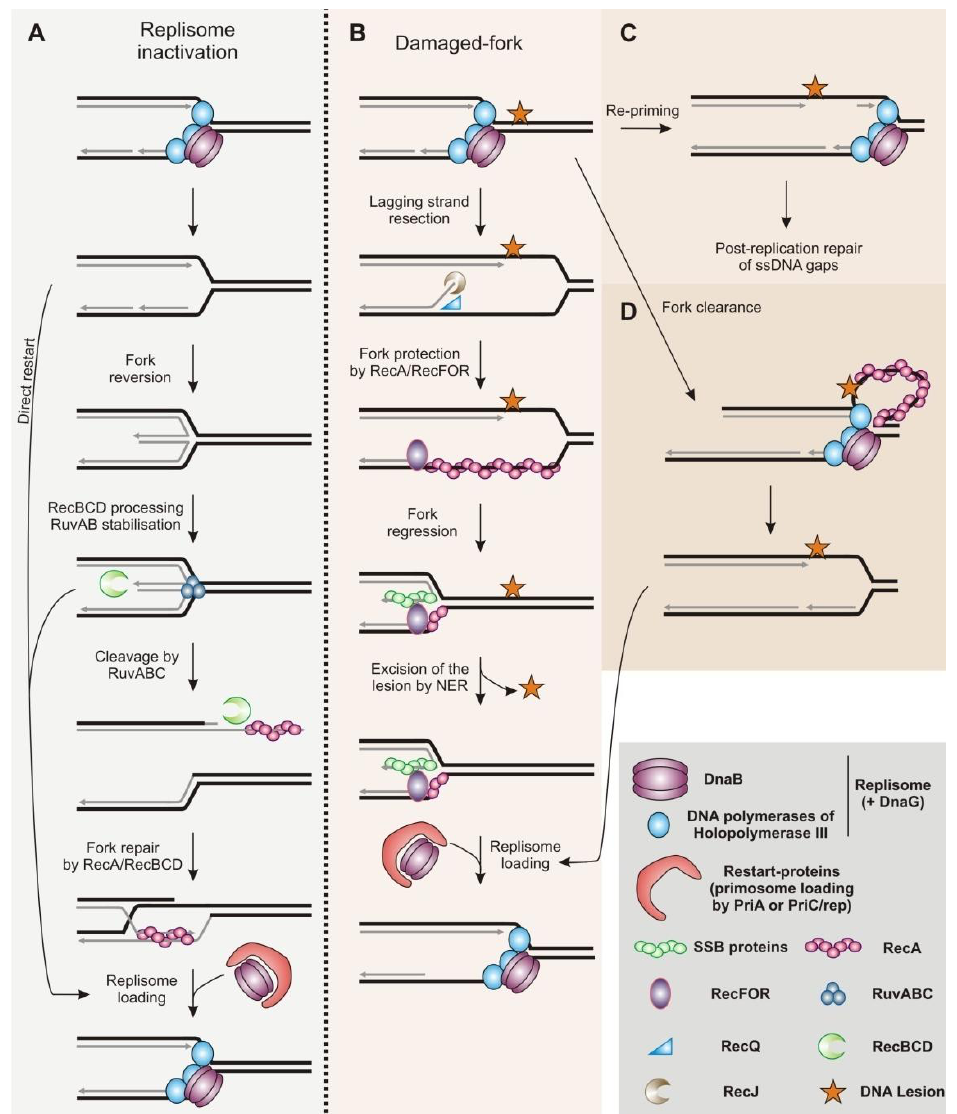
Figure2. Recombination function at replication forks in Bacteria (see text for